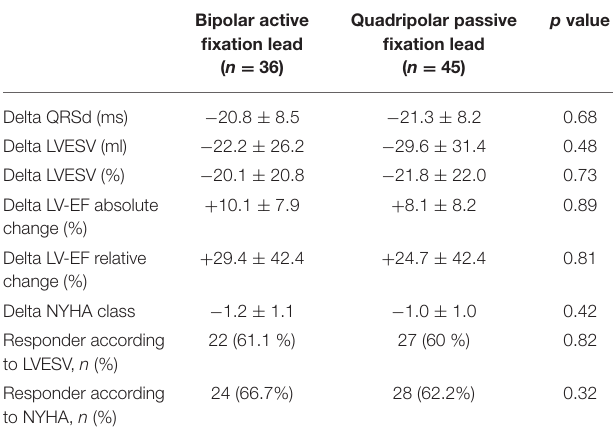
TABLE 2 | Clinical data during follow-up (baseline and 12-month follow-up). Bipolar active fixation